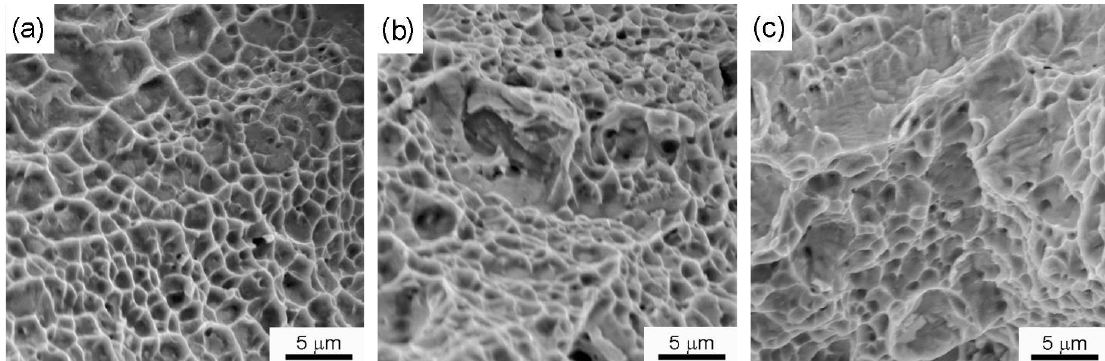
Figure 8. Room temperature tensile fracture morphology of ( a ) base metal, ( b ) as-welded, and ( c ) PWHT weld joints.